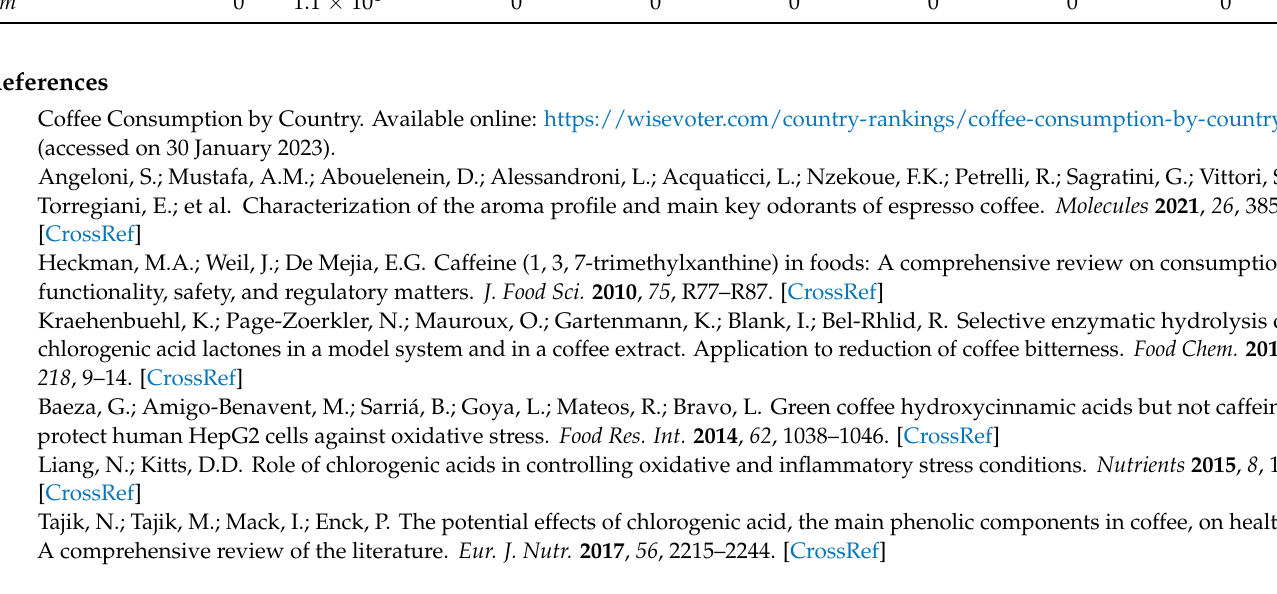
, k = CF, CQA, TR, CA, AA, TA, FA, LP, for the fine k